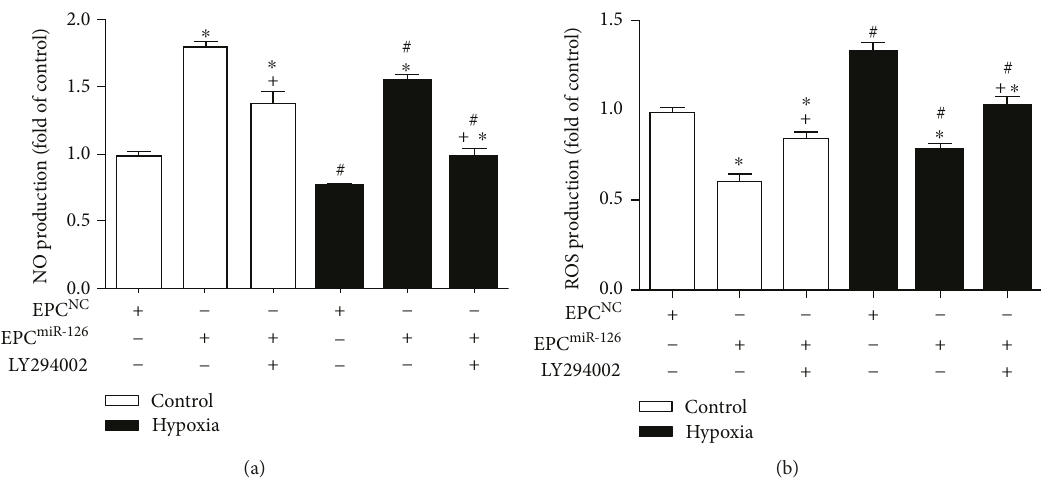
Figure 3: E ff ects of miR-126 overexpression on ROS and NO production in EPCs and hypoxia-injured EPCs. (a) NO generation of EPCs. (b) ROS production of EPCs. ∗ p < 0 05 versus EPC NC ; + p < 0 05 versus EPC miR-126 ; # p < 0 05 versus control, n = 3